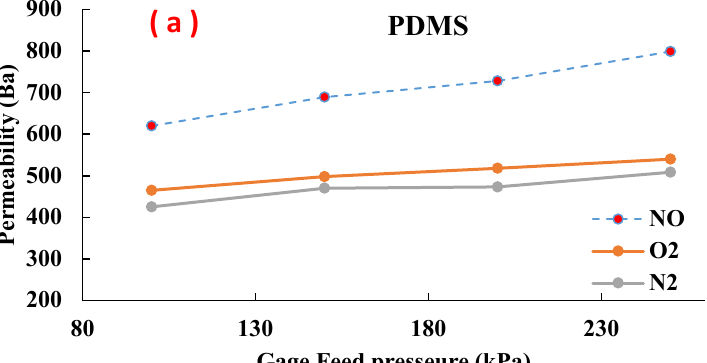
Fig.7 Effect of MOF loading in MMM on permeability (a,c,e and g) and selectivity (b, d, f and h) of NO, N